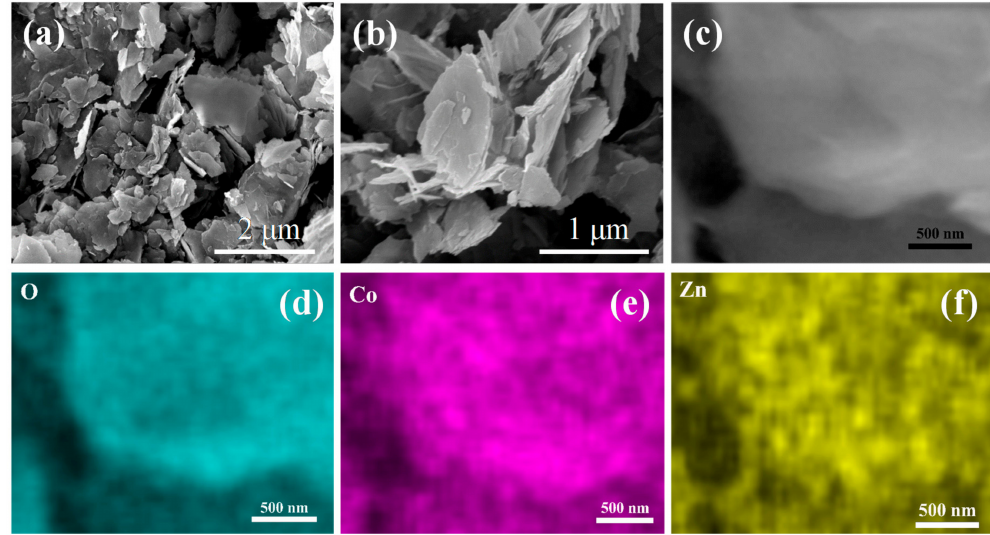
Figure 2. SEM images of the ZnCo 2 O 4 nanosheets ( a , b ) and the EDS mapping images of the ZnCo 2 O 4 nanosheets ( c – f ).